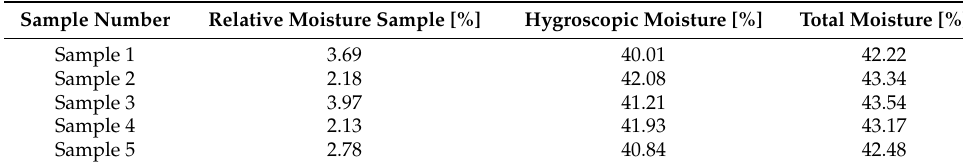
Table 2. Moisture content of the MSW.